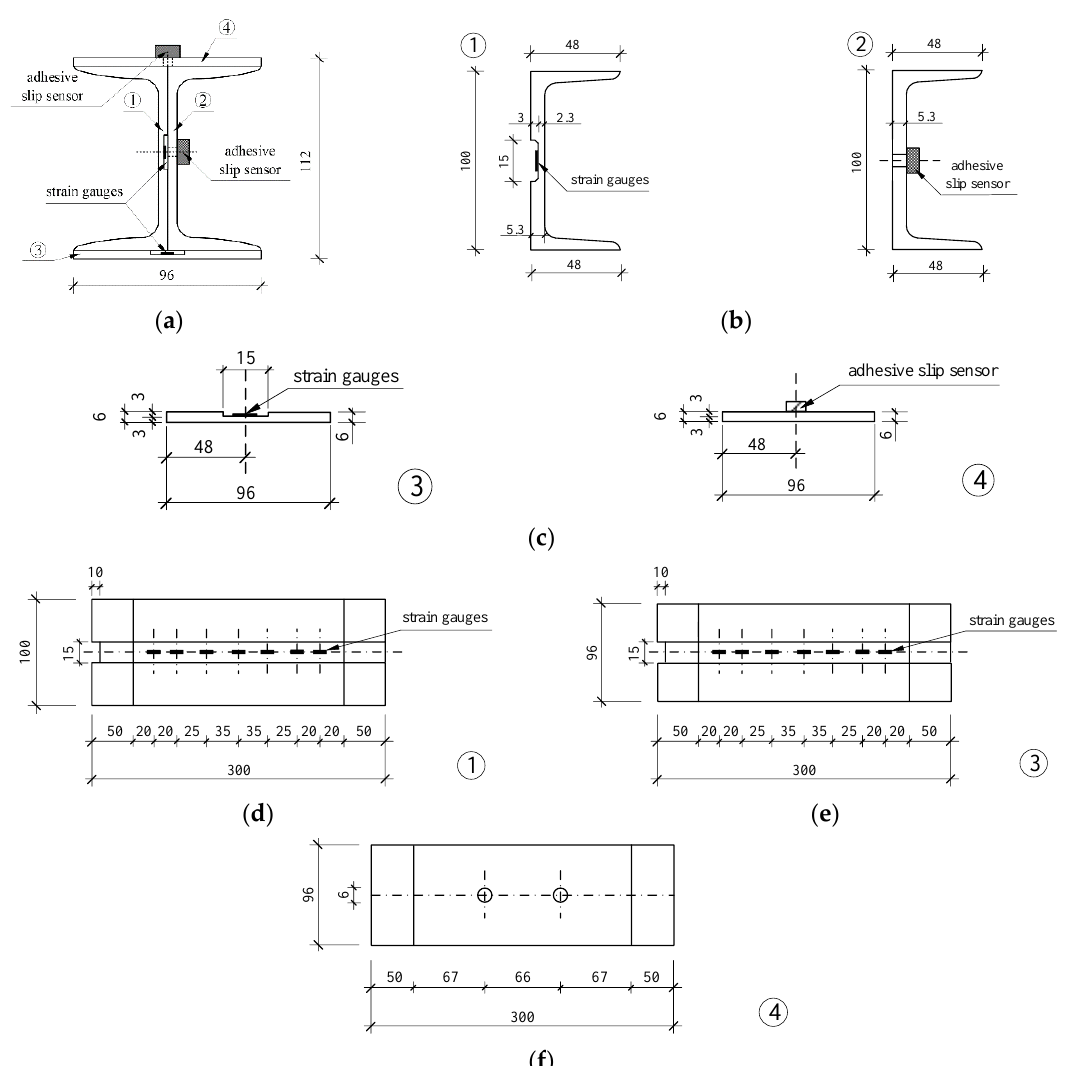
Figure 4. Measure arrangement of RCES specimen, they should be listed as: ( a ) Cross-section of H- shaped steel (mm); ( b ) Cross-section of channel steel (mm); ( c ) Cross-section of steel plate (mm); ( d ) Layout of strain gauges on web of channel steel (mm); ( e ) Layout of strain gauges on steel plate (mm); ( f ) Layout of adhesive sensors on steel plate (mm).